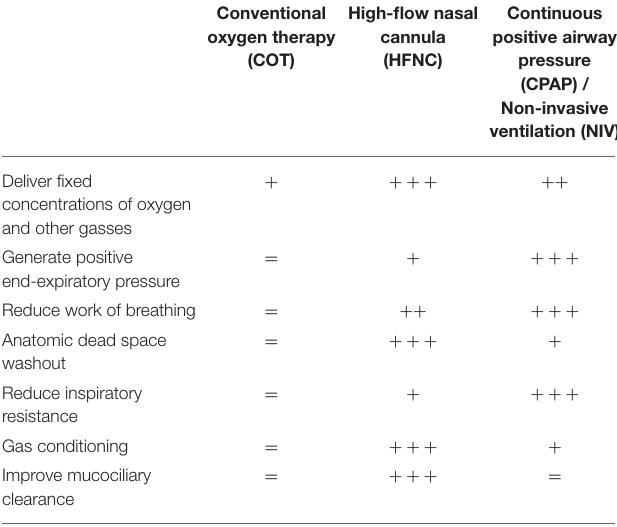
TABLE 1 | Physiological effects of COT, HFNC and